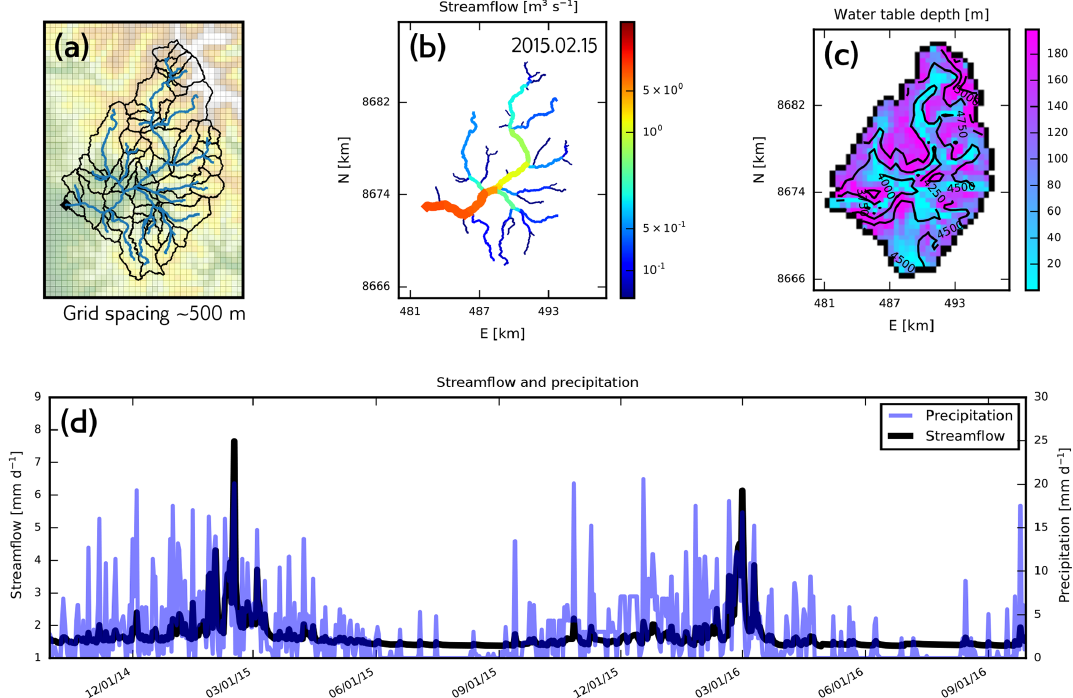
Figure 9. Model based on Río Shullcas, Peru. (a) Map with MODFLOW grid, HRU outlines, stream segments (blue), and digital elevation model. (b) Streamflow accumulation through the mountainous drainage network. (c) The modeled water table distribution with elevation contours (ma.s.l.). (d) Seasonally variable precipitation and